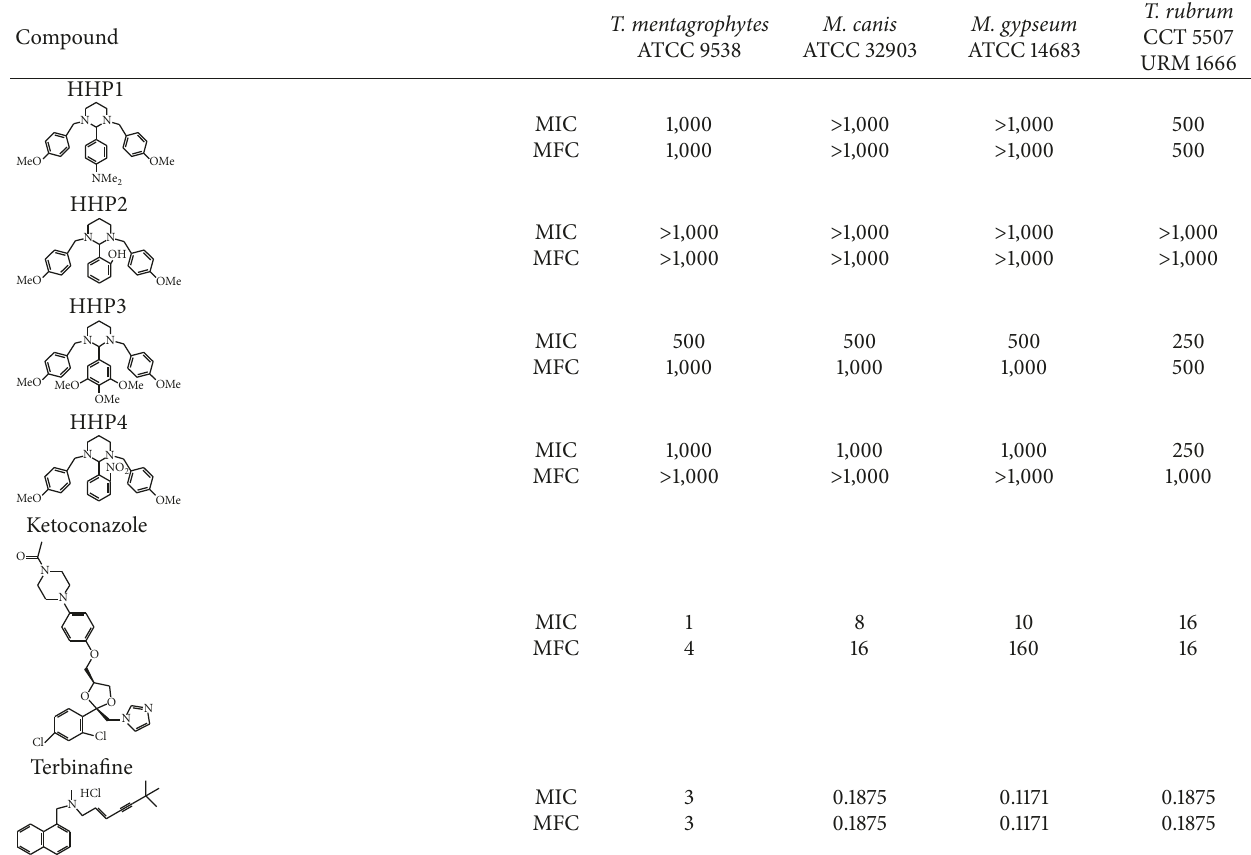
Table 1: Antifungal activity of hexahydropyrimidine derivatives and reference